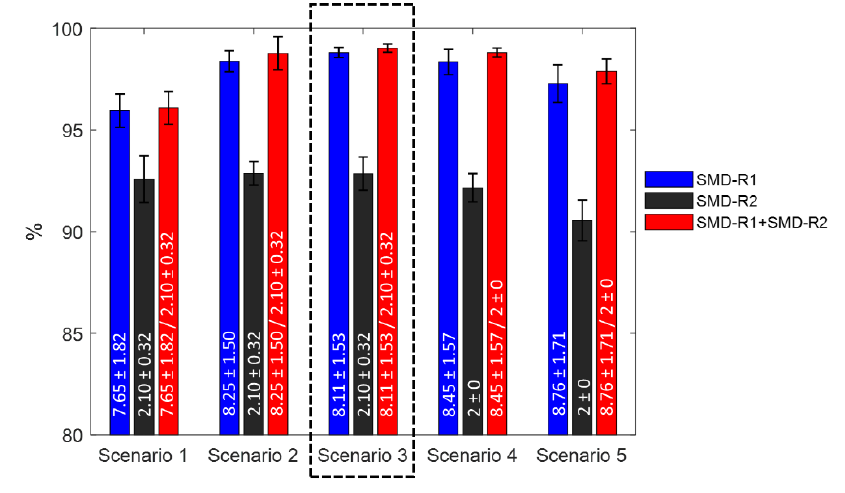
Figure 16. Classification results on the testing dataset for 5 scenarios.